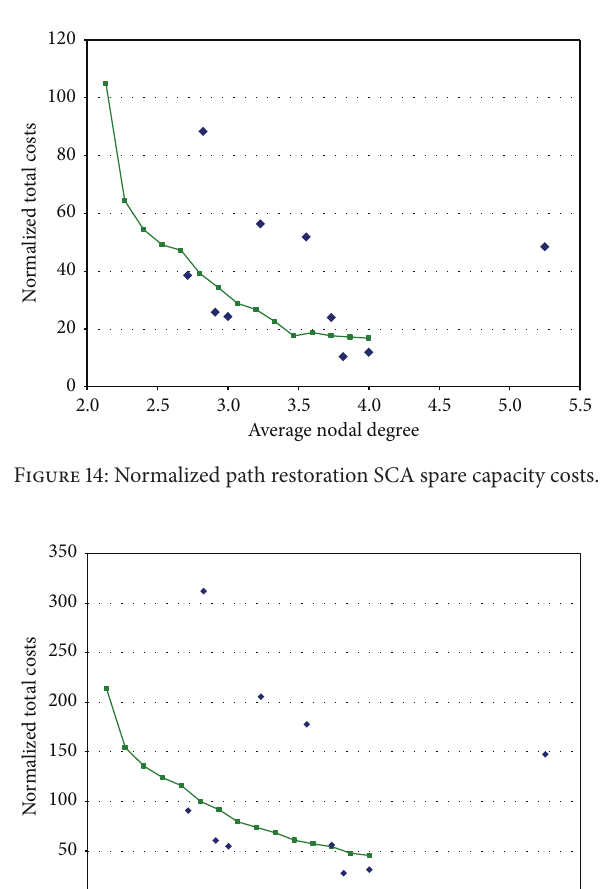
The green curve with square data points corresponds to